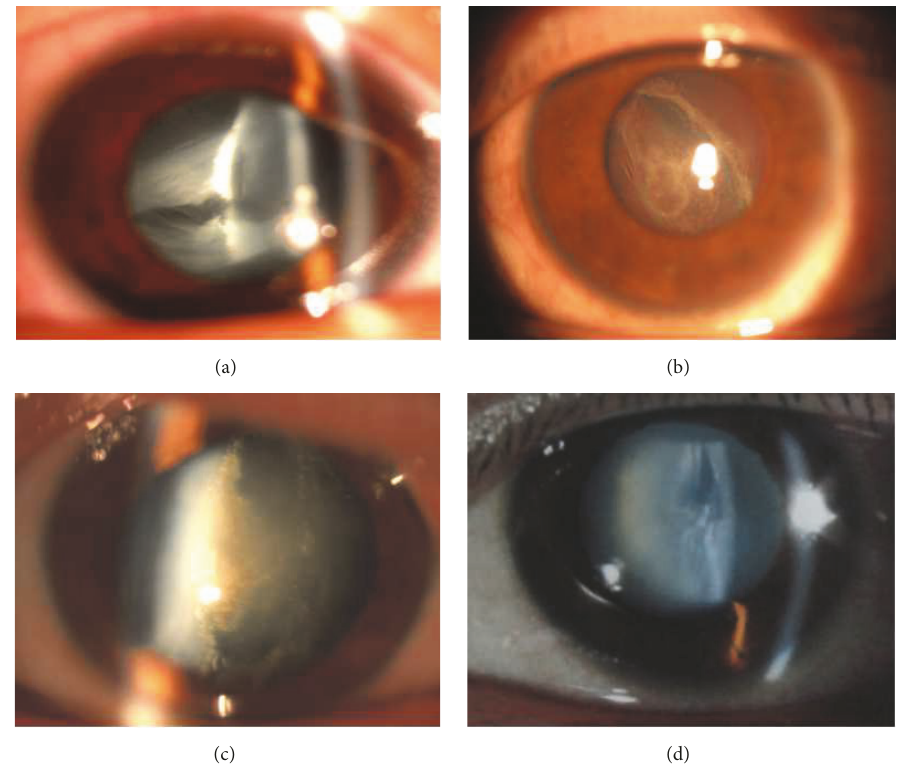
Figure 1: Preoperative slit-lamp photographs of Case 1 (a), Case 2 (b), Case 3 (c), and Case 4 (d). The posterior capsule ruptured transversely (Case 1) or longitudinally (Cases 2–4). A dense lens cortex is visible, especially in the area surrounding the ruptured parts.